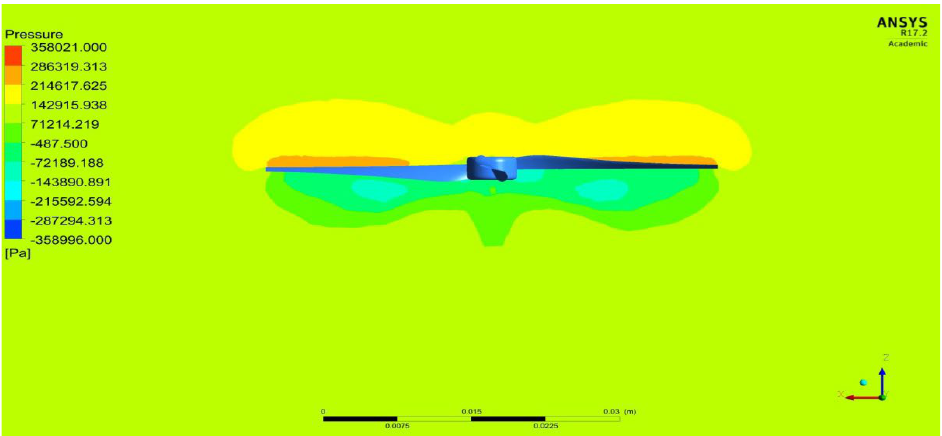
Figure 52. Hydrodynamic pressure variations over the UAV propeller under 8000 RPM with wave celerity of 12.10 m/s.